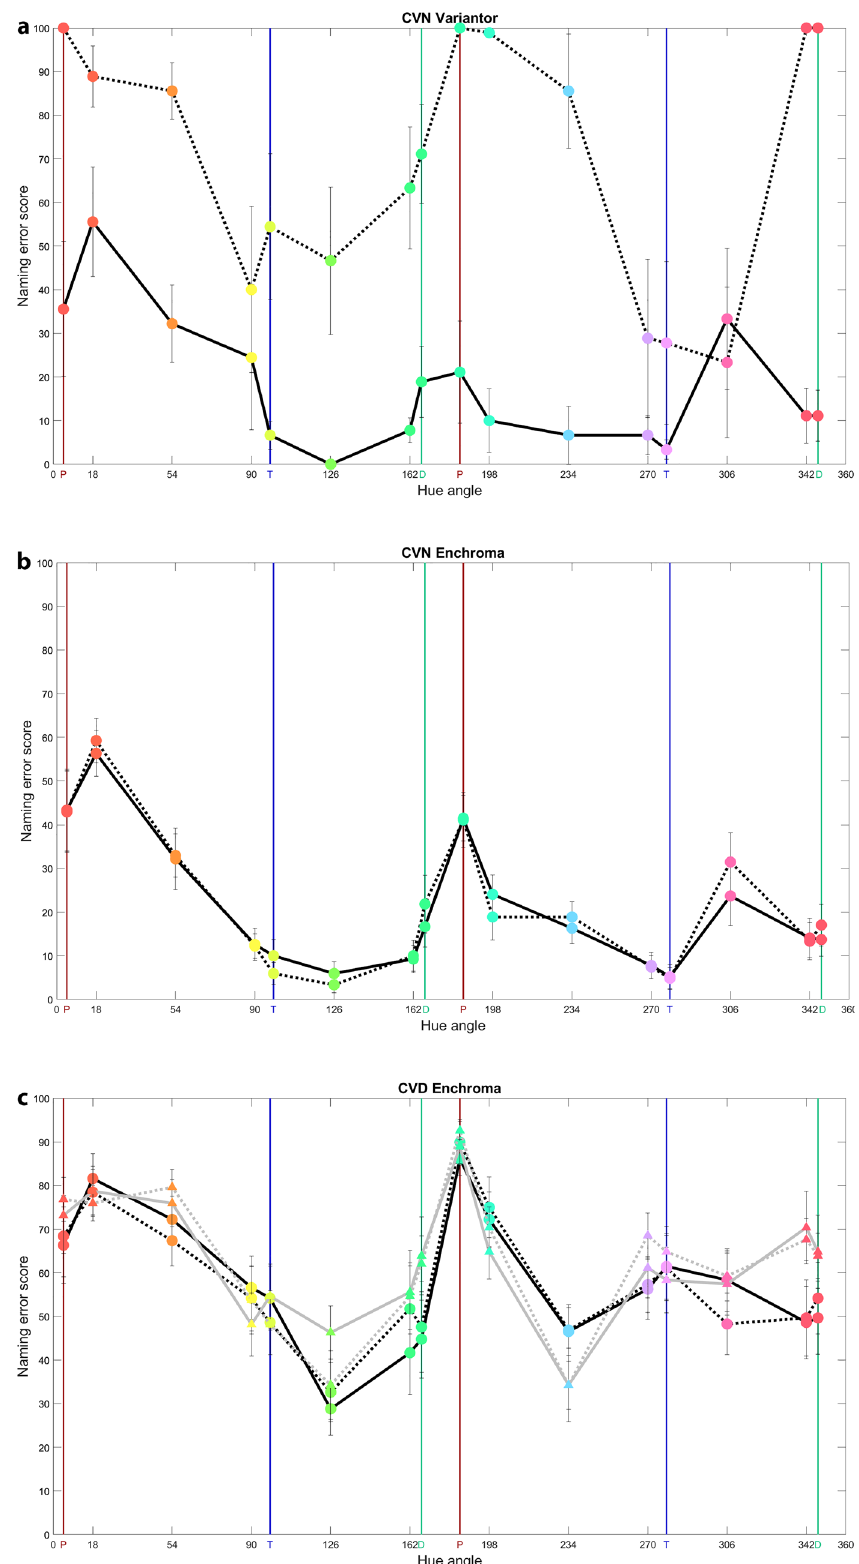
Figure 5. Mean naming results using CVA-UMinho task, with and without filters. Average naming error scores (100%—hit score%) on the CVA-UMinho colour naming task for the CVN-Variantor ( a ), the CVN-EnChroma ( b ) and the CVD- EnChroma ( c ) conditions without (solid) and with (dotted) filters with 5° (big circles along black lines) and 1° (small triangles along grey lines) stimuli. Marker colours are approximations of hues presented at maximum saturation. Vertical lines represent the two extremes of the protan (red), deutan (green) or tritan (blue) confusion lines. Error bars show ± 1 standard error of the mean